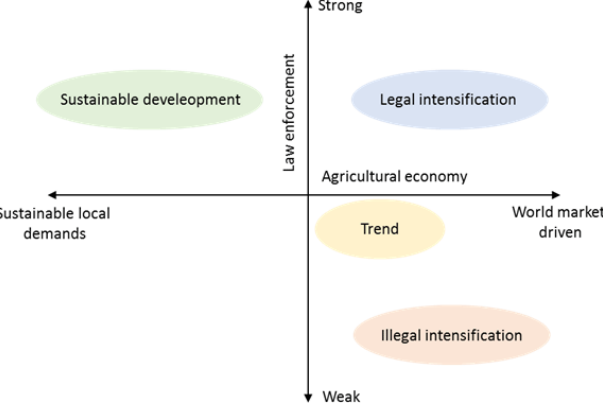
Fig. 3 . Scenario logic of